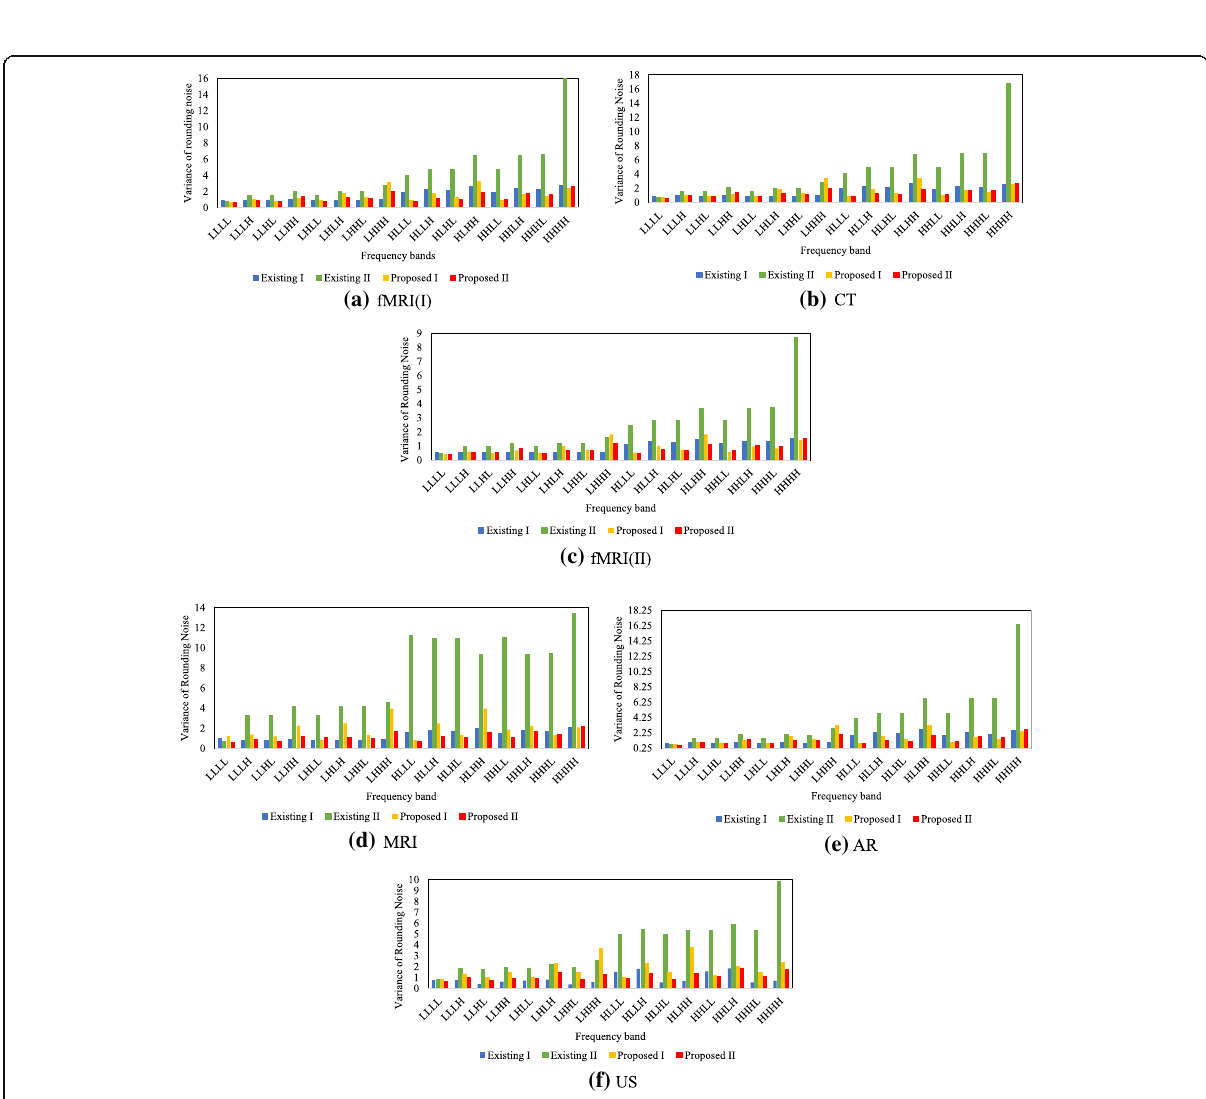
Fig. 16 Variance of rounding noise for all data in each frequency band. a fMRI(I). b CT. c fMRI(II). d MRI. e AR. f